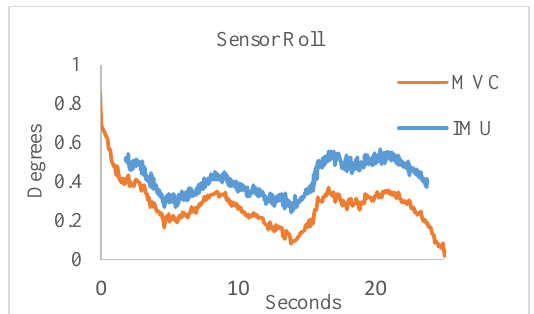
Figure 7 – Data from a single pass comparing the roll measured by the IMU and the roll as calculated from the MVC camera